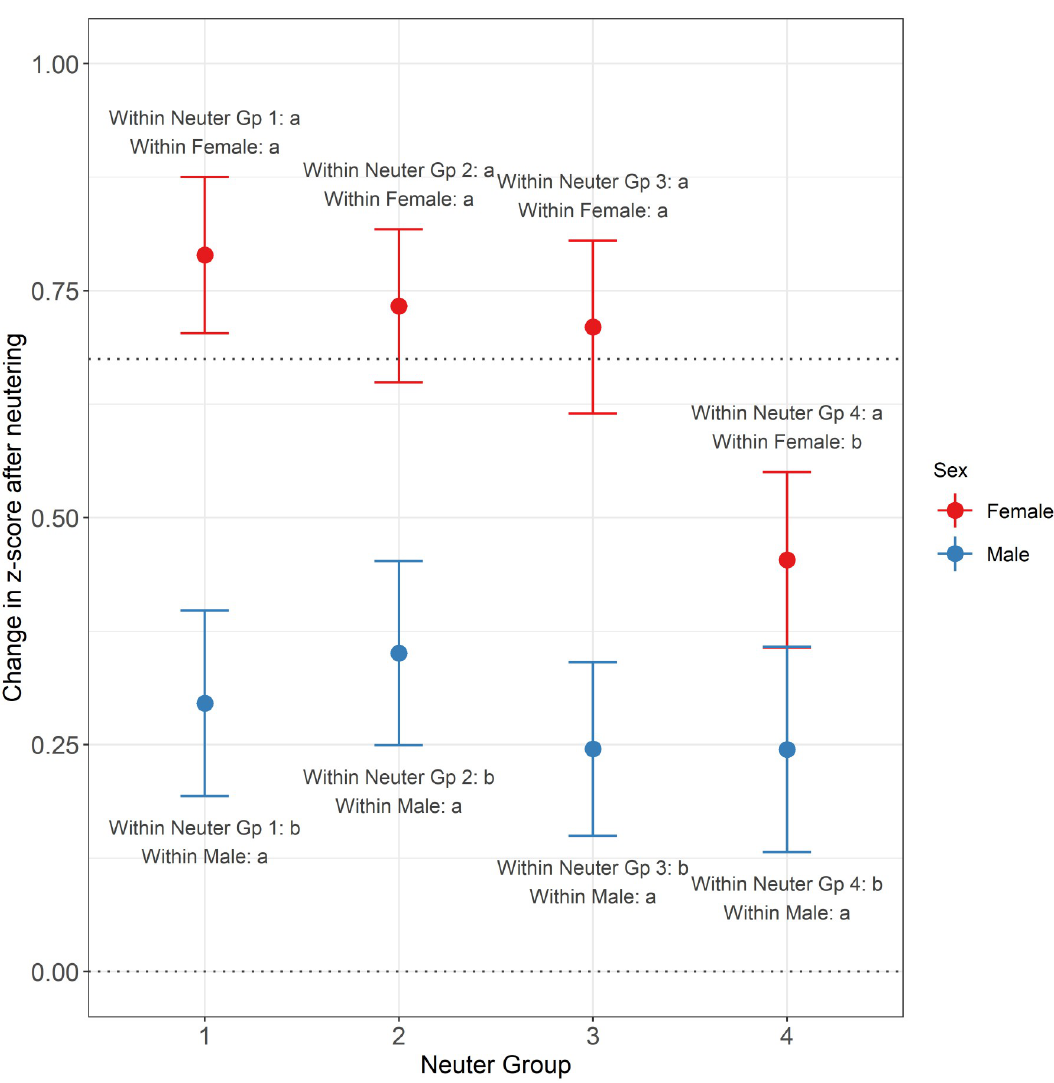
Fig 3. Estimated change in z-score post-neutering for a cat at median weight. Shown for different combinations of sex (female: Red; male: Blue) and neuter group, with 95% confidence intervals and Tukey post-hoc comparison groups. Neuter Groups 1–4 represent, respectively, neutering ages representing quartiles in the general neutered population–up to 20 weeks (448 cats), 20–23 weeks (451 cats), 23–28 weeks (507 cats) and > 28 weeks (364 cats) for males, and up to 21 weeks (628 cats), 21–25 weeks (653 cats), 25–29 weeks (515 cats) and > 29 weeks (497 cats) for females. The lower horizontal dotted line shows the point of zero change (meaning the cat remained on its initial centile line) and the upper horizontal dotted line represents an increase equal to one standard growth centile interval. The annotations give the Tukey post-hoc comparison groups, which indicate whether differences exist between estimated means for different combinations of neuter group and sex. Only comparisons between neuter groups of the same sex, and between sexes within the same neuter group were tested, and the groups within the relevant neuter group and relevant sex are as indicated in the annotations; within sets of means sharing the same neuter group or sex, those with different letters/numbers for that sex/group are significantly different at the 5% significance level. In all groups, there was a significant increase in z-score post neutering, and this was significantly larger in female than male.